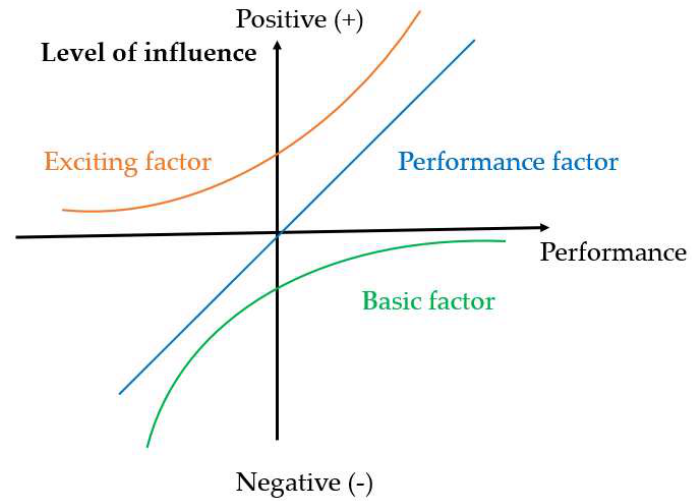
Figure 1. Three-factor theory (adapted from Kano et al., 1984) [34]. Lai and Wu (2013) [35] first applied the model to the study of transportation service satisfaction, demonstrating a nonlinear relationship between the level of satisfaction with BRT service and its quality. Based on the three-factor theory, Zhang et al. (2019) [36] identified attributes that determine the quality of service for buses, BRTs, and vans. By utilizing the same method, Cao and Cao (2017) [11] found that Guangzhou’s public transportation system should be evaluated on the basis of service satisfaction to provide better bus service and BRT services. Due to its ability to identify type differences and structural changes in samples, dummy variables are often used to evaluate the impact of different attribute variables on satisfaction. Using the dummy variable method, Wu et al. (2018) [12] found that the improvements focus on conventional public transportation and BRT services, as well as examined the asymmetric impact of performance factors on sat- isfaction with BRT services. The dummy variable method is employed in this paper to identify the improvement direction of metro routine service and pandemic prevention service. Through the literature review, we identified three gaps that motivated this re- search:(1) previous literature evaluating transit services has focused only on the rela- tionship between routine services and passenger perceived satisfaction. When there is an unexpected public health crisis, the transportation sector introduces new pandemic pre- vention services. The relationship between these pandemic prevention services and pas- senger satisfaction has not been explored. (2) Previous literature has only explored the pandemic prevention measures needed to improve transit services during a pandemic based on qualitative analysis, but there is a lack of quantitative studies exploring the ef- fectiveness and necessity of these pandemic prevention measures to reduce people’s safety concerns. (3) Methodologically, previous studies have used structural equation modelling to verify the interactions among service factors but have been unable to sug- gest more specific directions for service improvement. Other studies used a three-factor theory analysis of the elements of service improvement, but the validity of the theoretical analysis framework could not be verified. In conclusion, few studies have combined the two approaches to conduct a holistic study of the relationships between service factors and directions for improvement. To fill the knowledge gap, this paper introduces pandemic prevention services into the traditional metro service evaluation model and constructs a new evaluation model under a public health crisis. Then, based on the Shanghai Metro passenger survey data, we use structural equation modeling to explore the mechanism of improving basic and